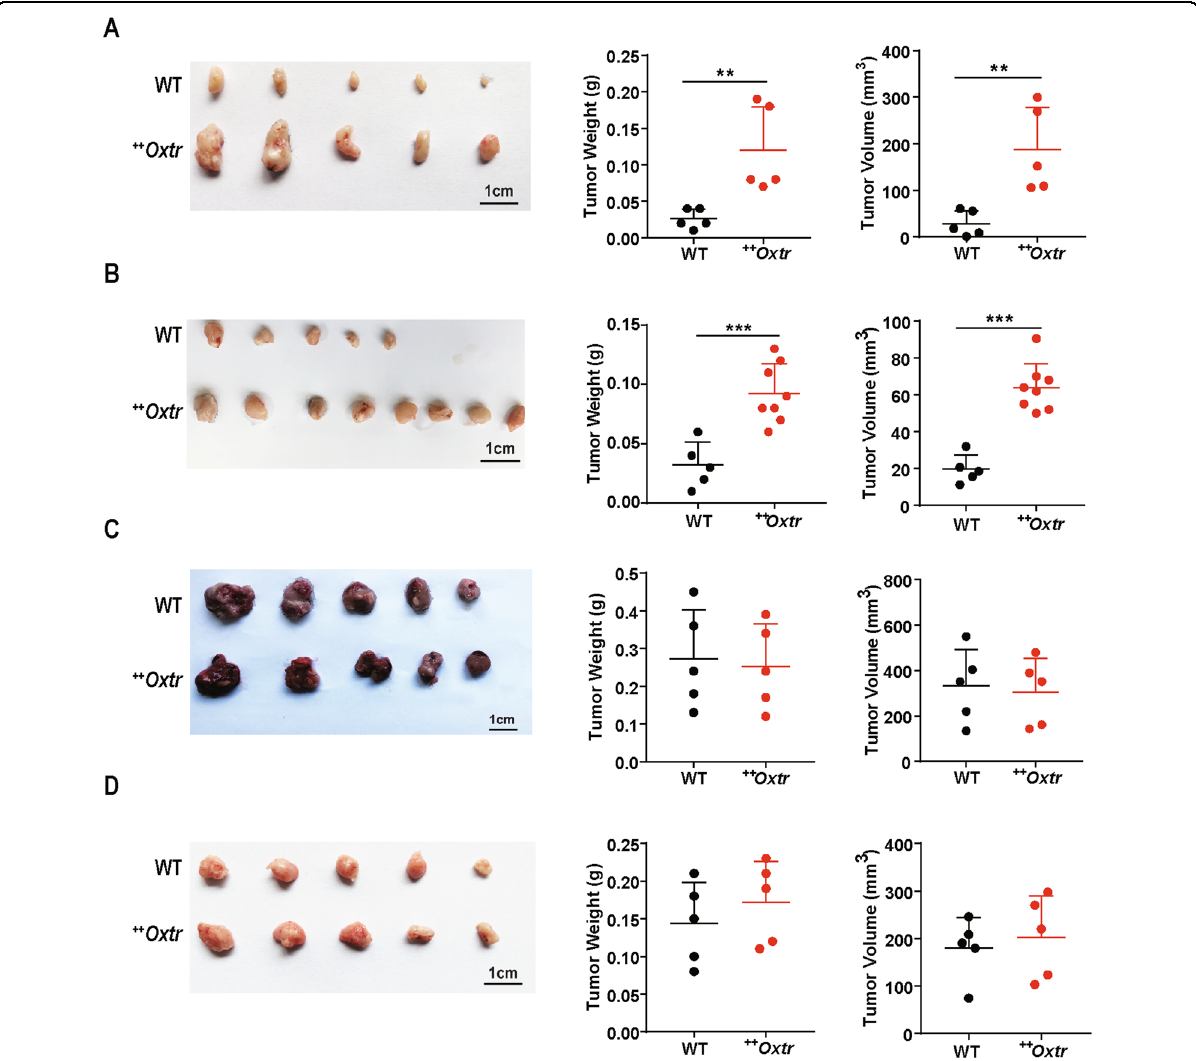
Fig. 6 OXTR overexpression promotes mammary tumor growth, not melanoma or cervical tumor. For tumor growth analysis, ++ Oxtr tumor fragment, E0771, B16, or U14 cells were orthotopically transplanted into fourth mammary gland of 3-month-old WT and ++ Oxtr females. Tumors were analyzed on day 15 after transplantation. A Representative photos of mammary tumors from ++ Oxtr tumor fragment, Scale bar: 1 cm. Quantitative analysis of mammary tumor weights ( n = 5) and volumes ( n = 5). B Representative photos of mammary tumors from E0771 cells, Scale bar: 1 cm. Quantitative analysis of mammary tumor weights ( n = 5 from WT and n = 8 from ++ Oxtr ) and volumes ( n = 5 from WT and n = 8 from ++ Oxtr ). C Representative photos of melanoma tumors from B16 cells, Scale bar: 1 cm. Quantitative analysis of melanoma tumor weights ( n = 5) and volumes ( n = 5). D Representative photos of cervical tumors from U14 cells, Scale bar: 1 cm. Quantitative analysis of cervical tumor weights ( n = 5) and volumes ( n = 5). Data were represented as mean ± SD. ** P < 0.01, *** P < 0.001, calculated using two-tailed unpaired t